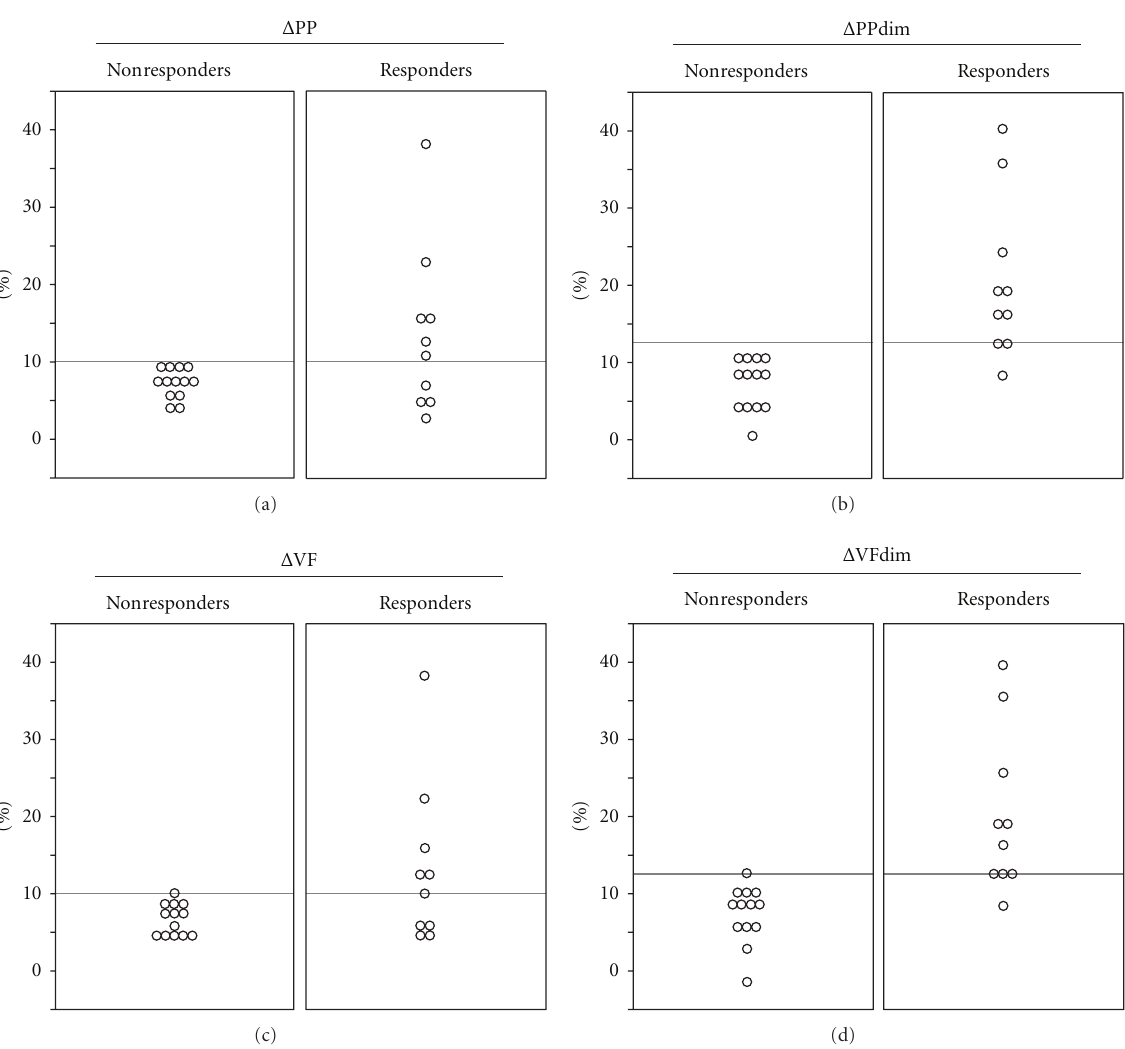
Figure 3: Individual baseline values for each indicator, respiratory change in pulse pressure ( Δ PP), respiratory change in velocity peak of femoral artery flow ( Δ VF), deep inspiration maneuver-induced change in pulse pressure ( Δ PPdim), and deep inspiration maneuver-induced change in velocity peak of femoral artery flow ( Δ VFdim) in patients with volume expansion-induced changes in SV ≥ 15% (responders) and < 15%